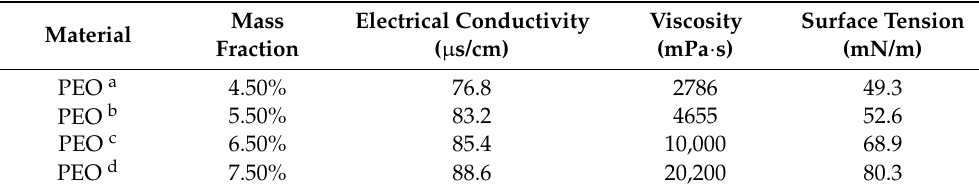
Table 2. Tests of physical properties with different mass